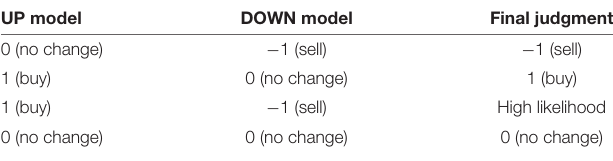
TABLE 1 | Polarity judgment